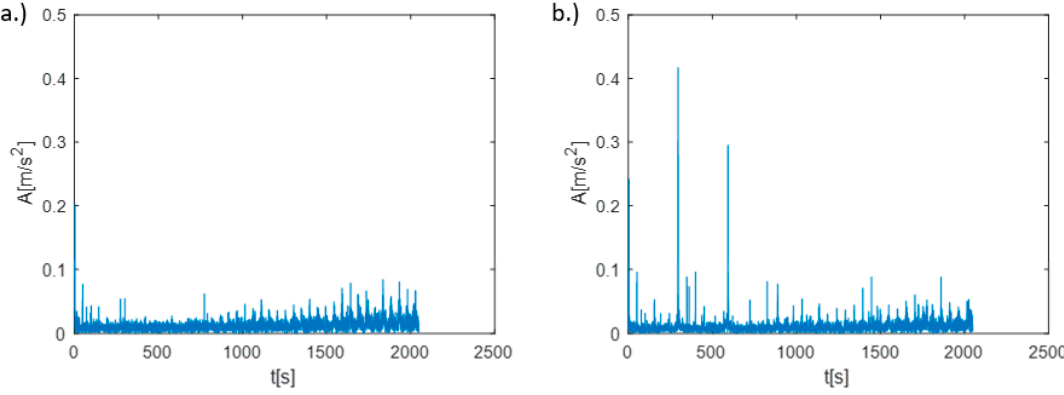
Figure 13. The FFT of vibrations measured during the machining, test “2”: ( a ) section 1, ( b ) section 2.